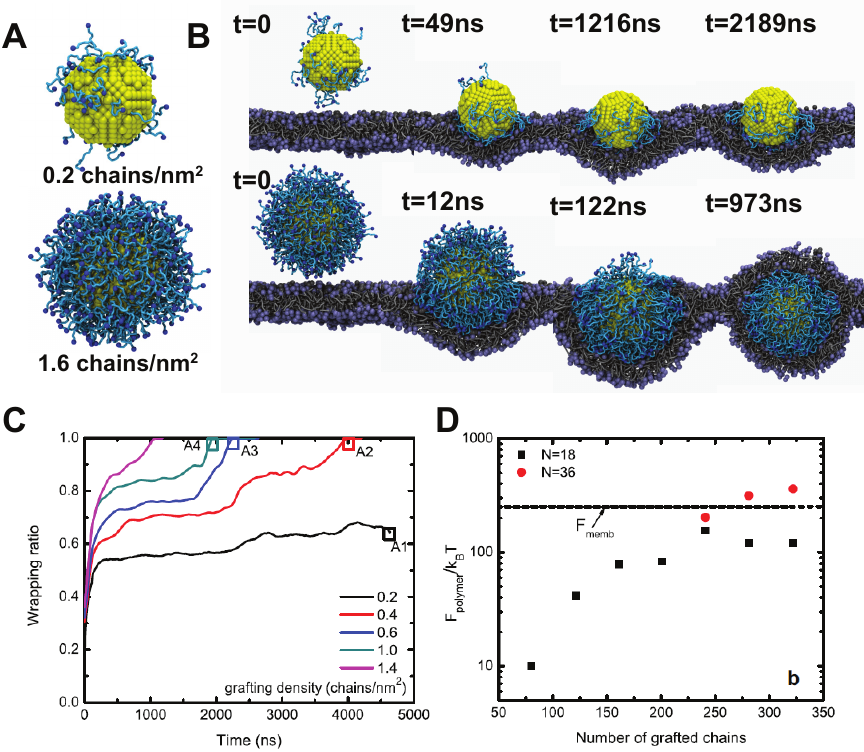
Figure 7. Internalization process of PEGylated NPs and related free energy change. ( A ) Snapshots of PEGylated NPs used in the dissipative particle dynamics (DPD) simulations with two grafting densities: 0.2 and 1.6 chains/nm 2 . The diameter of the NP core is about 8 nm. The polymerization degree of tethered chains is 18, corresponding to the molecular weight 838 Da; ( B ) Endocytosis of PEGylated NPs with different grafting densities. When the grafting density is low, i.e. , 0.2 chains/nm 2 , the NP will be trapped on the surface of membrane. While for high grafting density, 1.6 chains/nm 2 , the NP will be fully wrapped by the membrane; ( C ) Wrapping ratio versus time for PEGylated NPs with different grafting densities; ( D ) Free energy change of the tethered polymers during endocytosis. The dashed line represents the bending energy of the